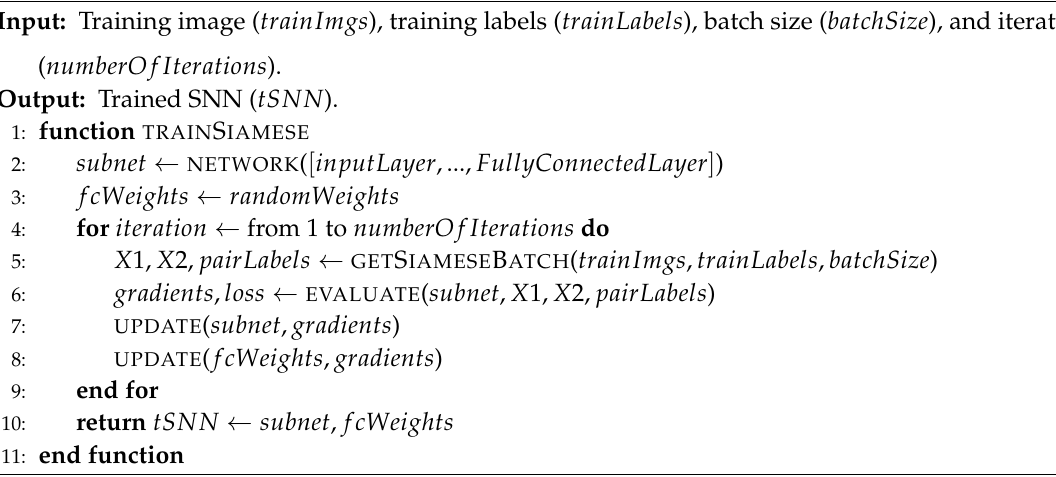
Algorithm 3 Siamese training pseudocode